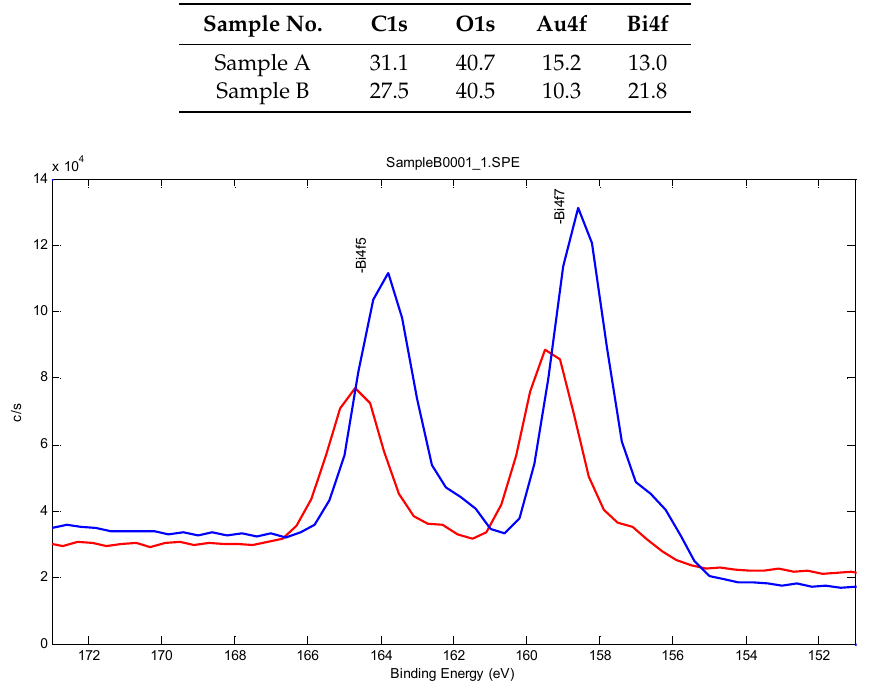
Figure 3. Bismuth 4d 7/2 peak from the Survey spectrum compared for samples A (red) and B (blue).